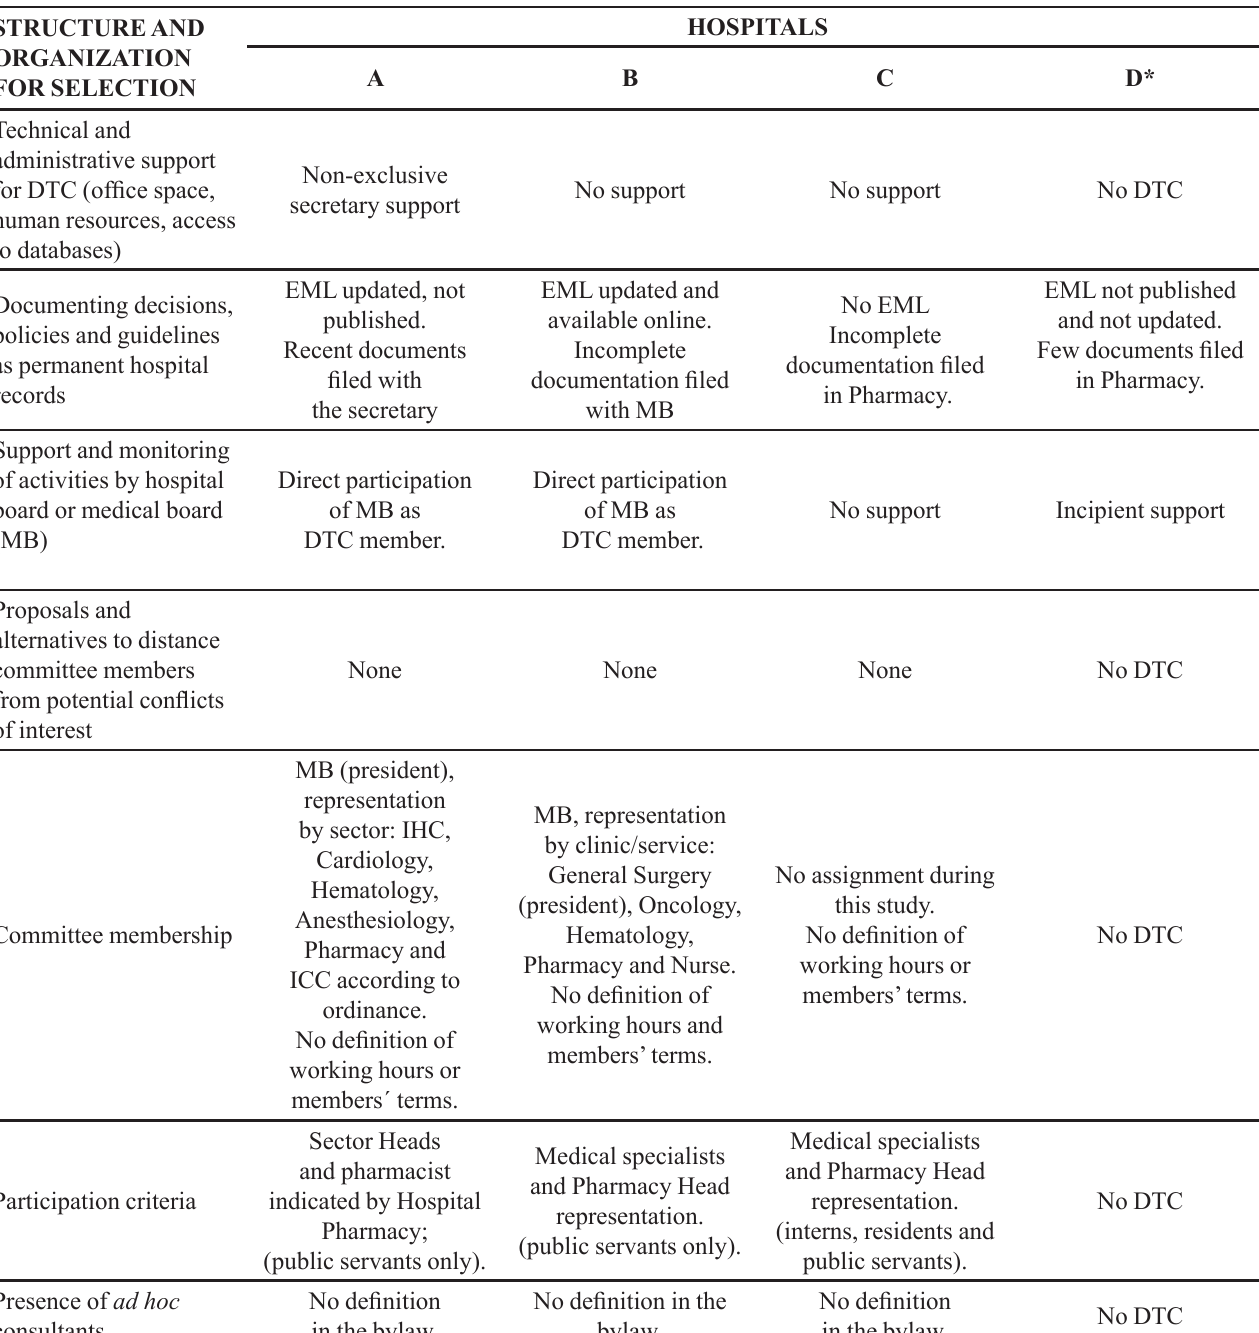
TABLE III - Structure and organization of DTCs (or other) related to medicine selections in university hospitals. State of Rio